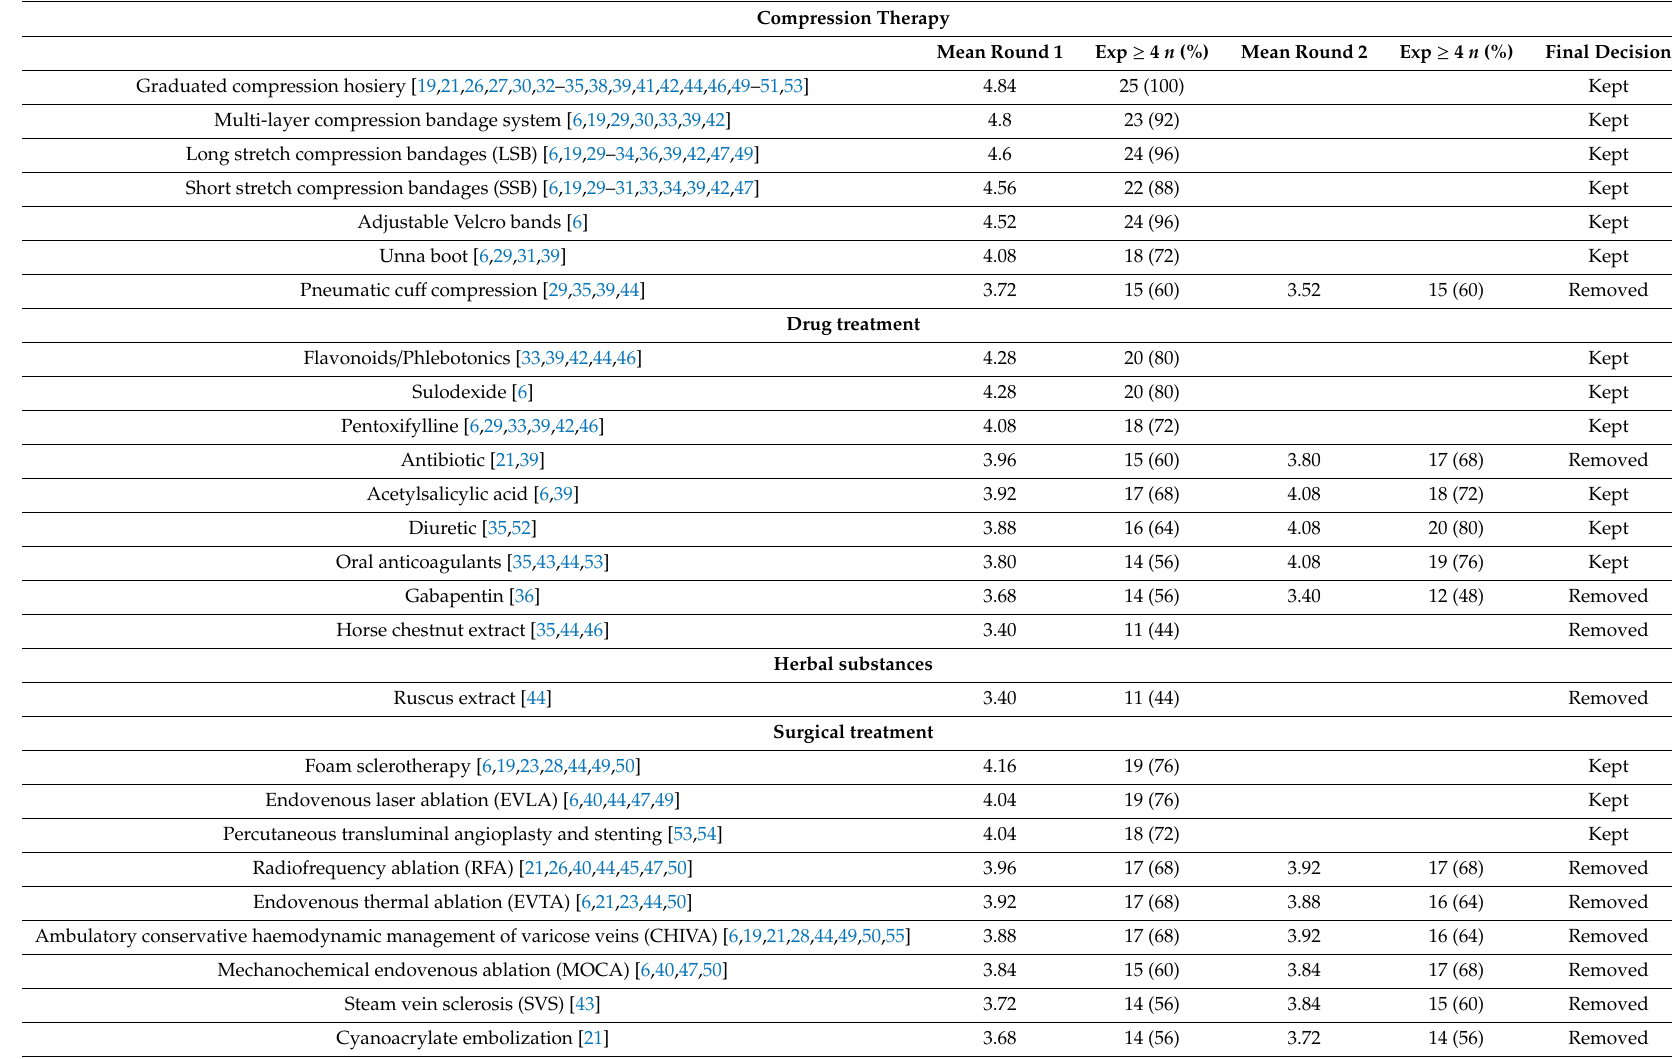
Table 3. Items related to treatments to manage all stages of venous